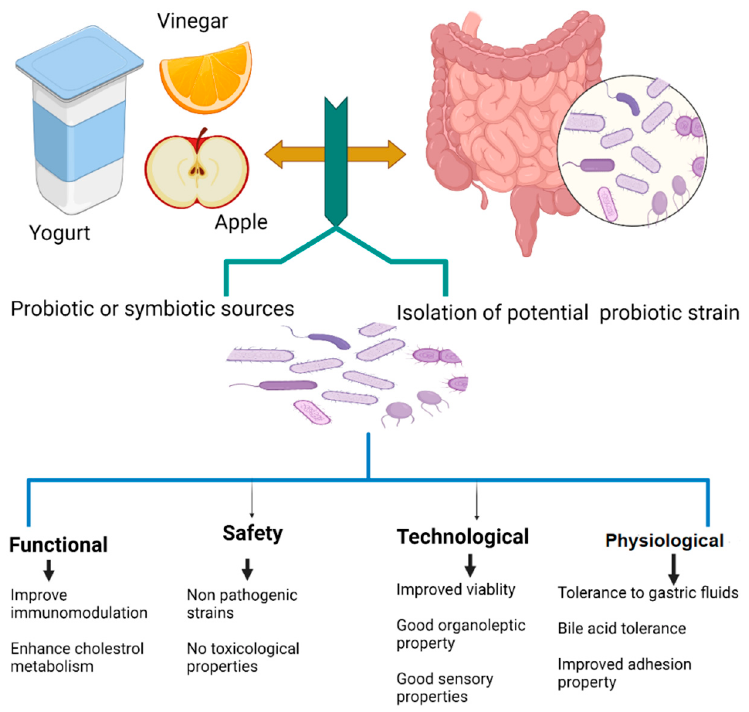
Figure 1. Basic criteria for selecting suitable probiotic strain for specific applications.